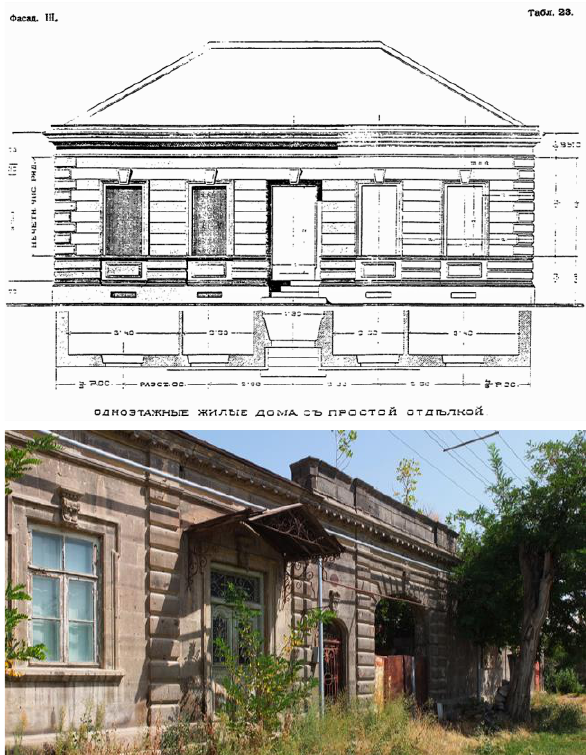
Figure 7. Table from an album (Brausevetter, 1904); residential building on Tumanyan Street (early 20th century) mostly likely built as per a similar catalogue and completed with a grand arched gate. Photo by the author, 2016.